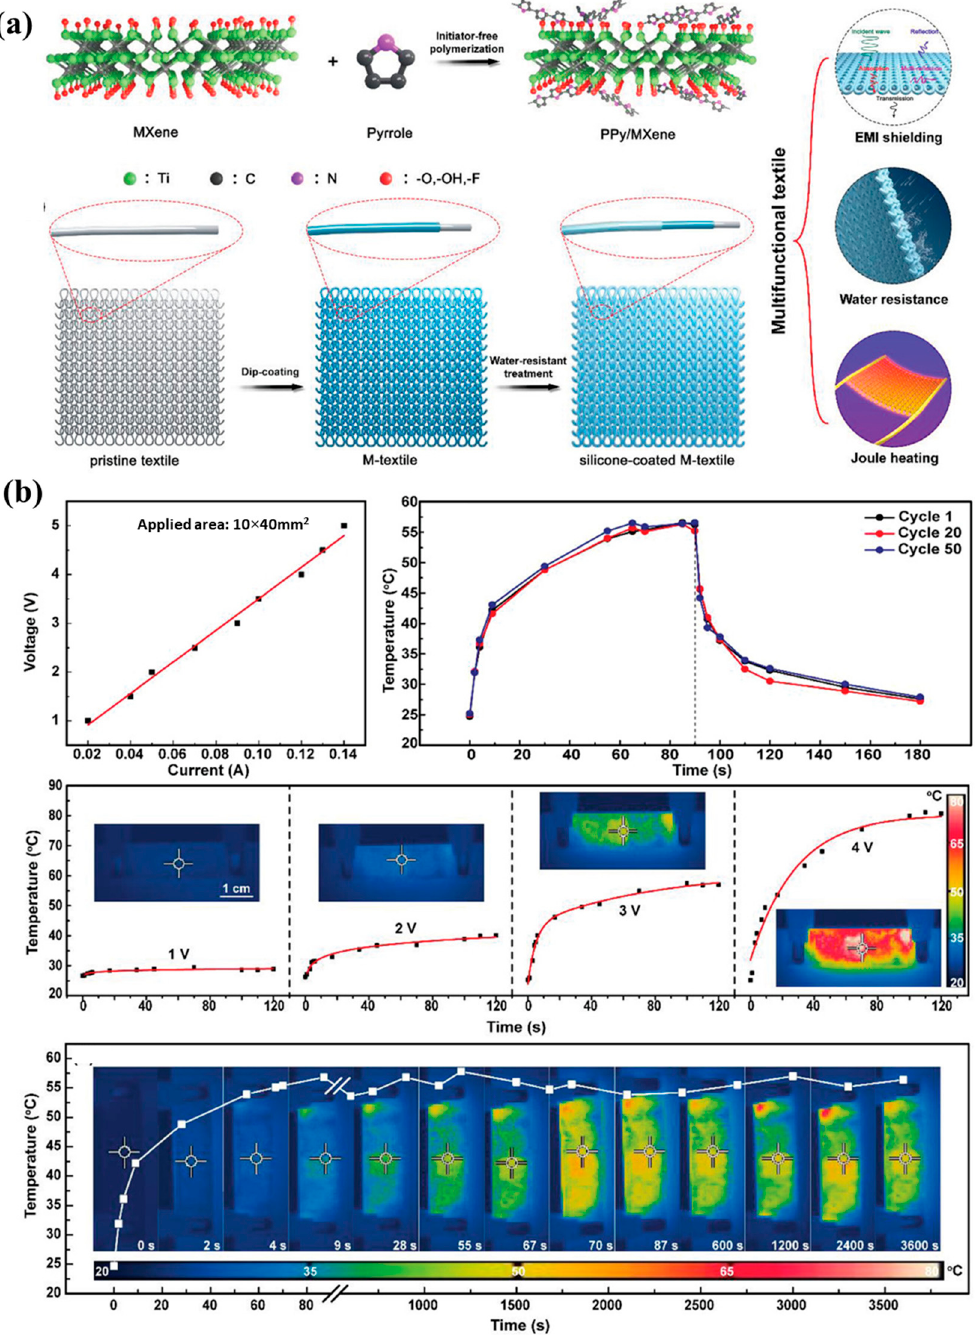
Figure 12. ( a ) Schematic illustrating MXene with in situ polymerized PPy, and its fabrication of PPy/MXene-decorated PET textile and the multifunctional silicone-coated M-textile. ( b ) I–V curve with Joule heating performances of silicone-coated M-textile and time–temperature curve at a constant voltage of 3 V for silicone-coated M-textile